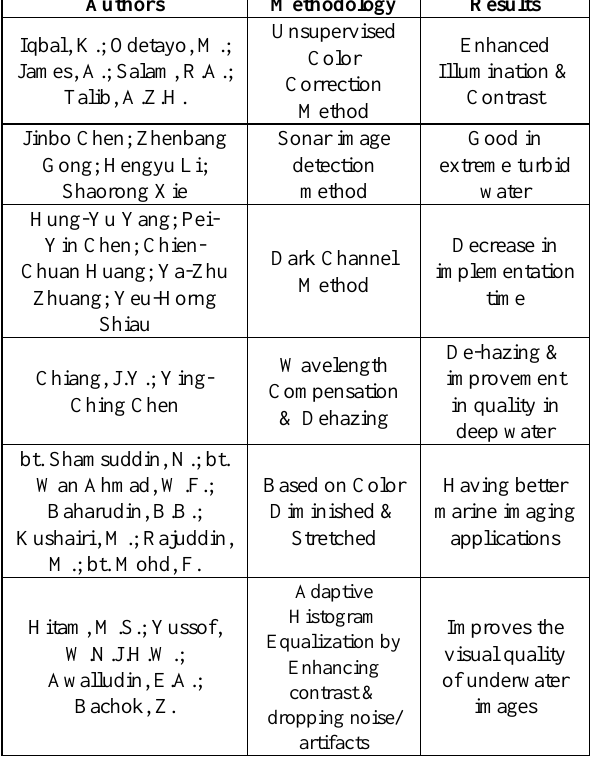
Table 1. Underwater Image Enhancement Techniques (Pooja Sahu et al, 2014)